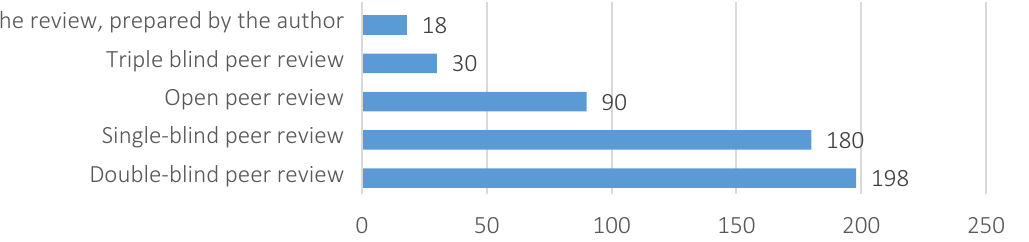
Figure 1. Distribution of answers to the question “What model of review did you work on?”